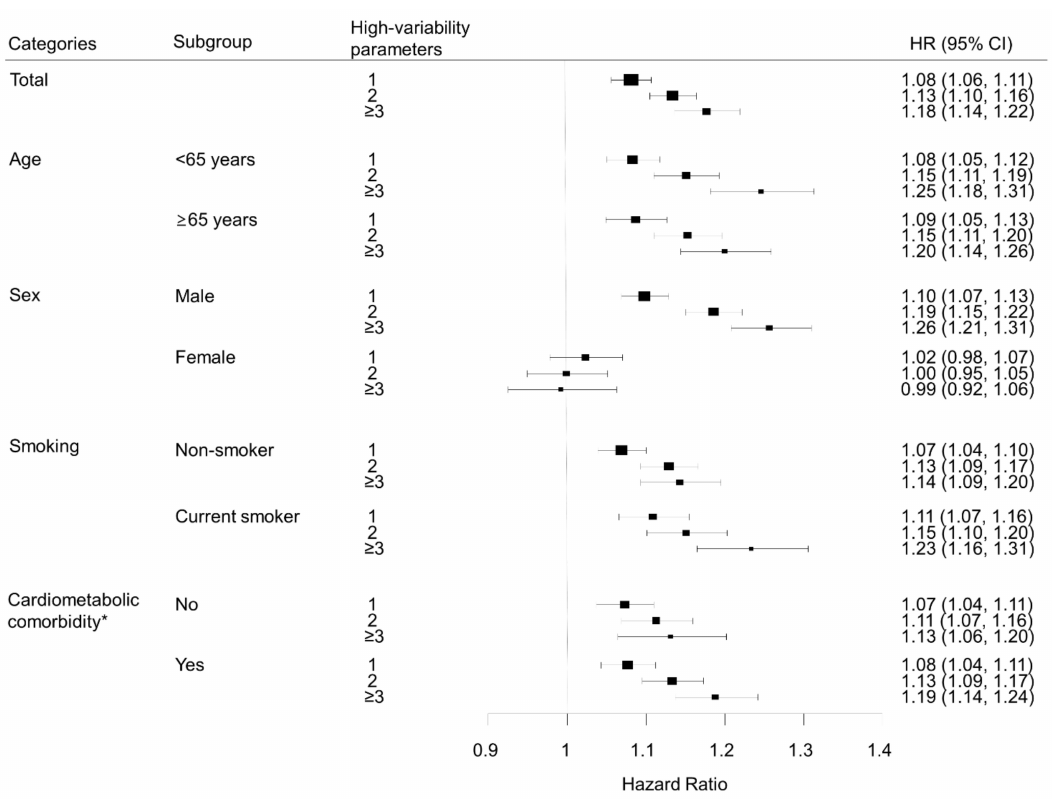
Figure 3. Subgroup analysis of the association between number of high-variability parameters and lung cancer, analyzed by age, sex, smoking status, and cardiometabolic comorbidity. All hazard ratios (HR) are adjusted for age, sex, alcohol consumption, smoking, regular exercise, household income, baseline fasting blood glucose, total cholesterol, systolic blood pressure, and body mass index. * Cardiometabolic comorbidity was defined as the presence of any of hypertension, diabetes mellitus, or dyslipidemia.